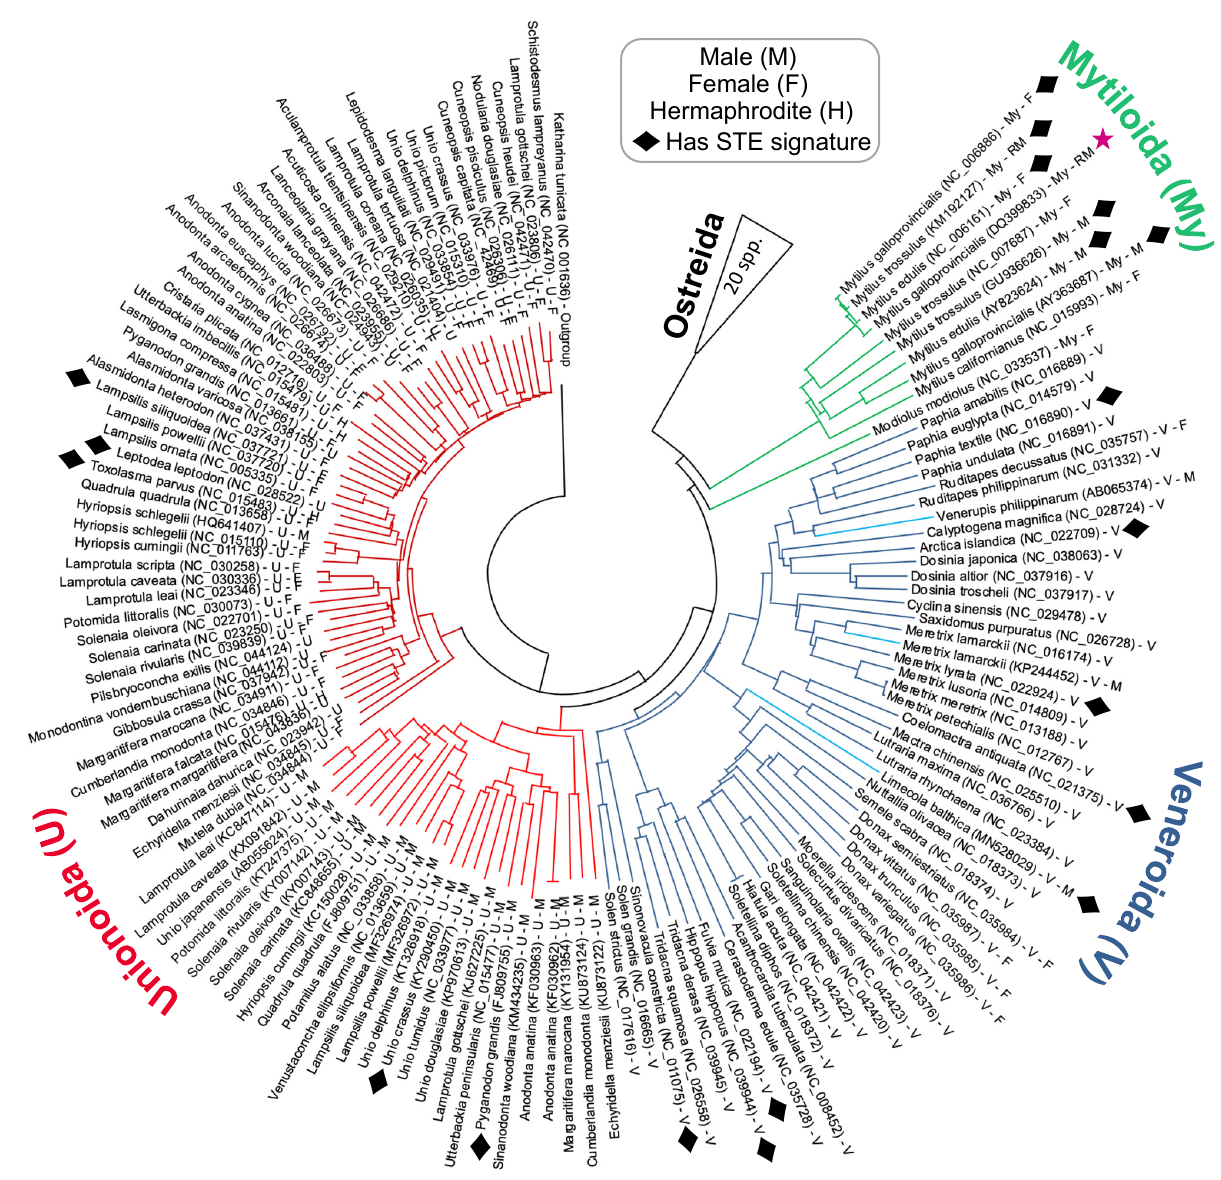
Figure 4. Taxonomic distribution of STE-like signatures discussed in this study. The phylogeny is a Neighbor-joining tree with 1000 bootstrap replicates reconstructed in MEGAX [32,33]. Full-length co1 genes were aligned using MUSCLE [27] and trimmed to a conserved start/end nucleotide. Bootstrap values are shown in the expanded version of this phylogeny in Figure S1. ★ = Known STE motif from Kyriakou et al. [10]. The Hyriopsis schlegelii male sequence is likely an F ‐ type genome derived from a male individual [43].